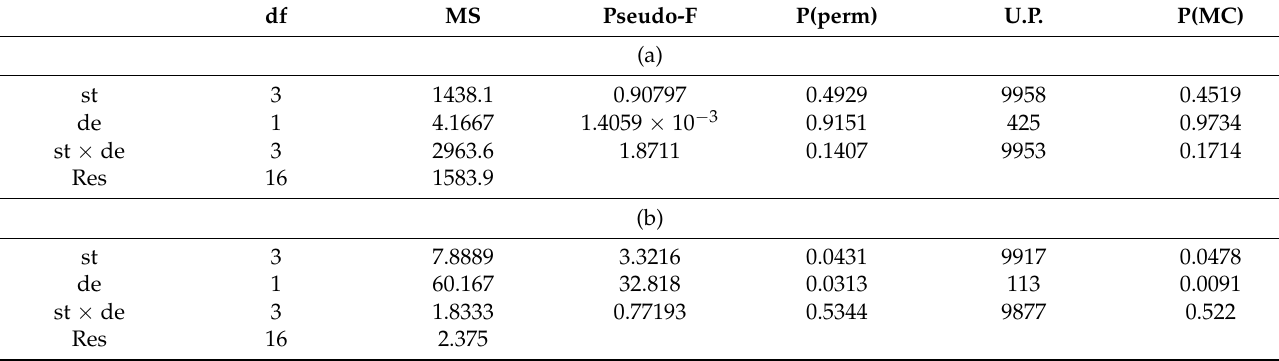
Figure 2. Abundance (number of individuals, mean + SE) and species richness (number of species, mean + SE). Table 2. ANOVA testing differences among stations and between depths in abundance (a) and species richness (b). st = station, de = depth, df = degrees of freedom, MS = mean squares, Pseudo-F = statistics, P (perm) = p -values calculated by permutations, P(MC) = p -values calculated by Monte Carlo sampling, U.P. = unique perms, Res =